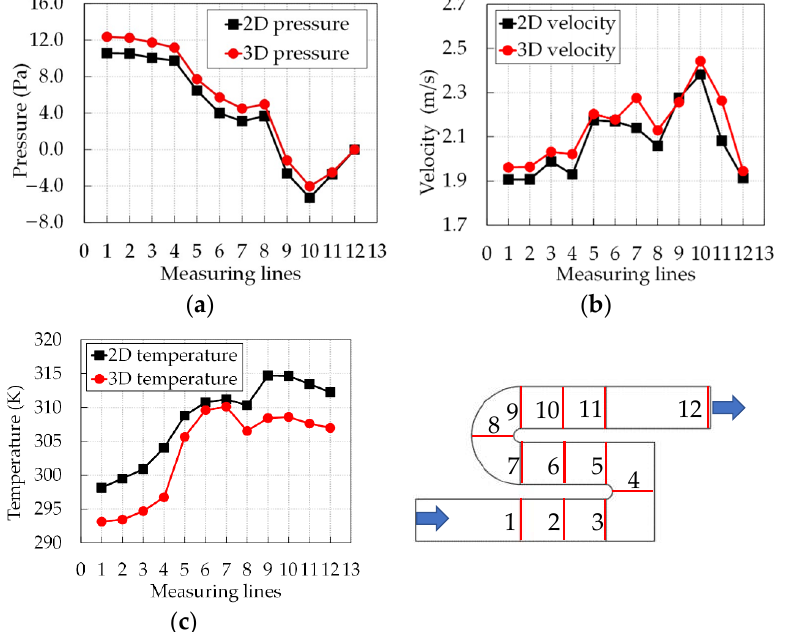
Figure 5. ( a ) The mesh system for 2D model validation; ( b ) mesh system in the 3D model.